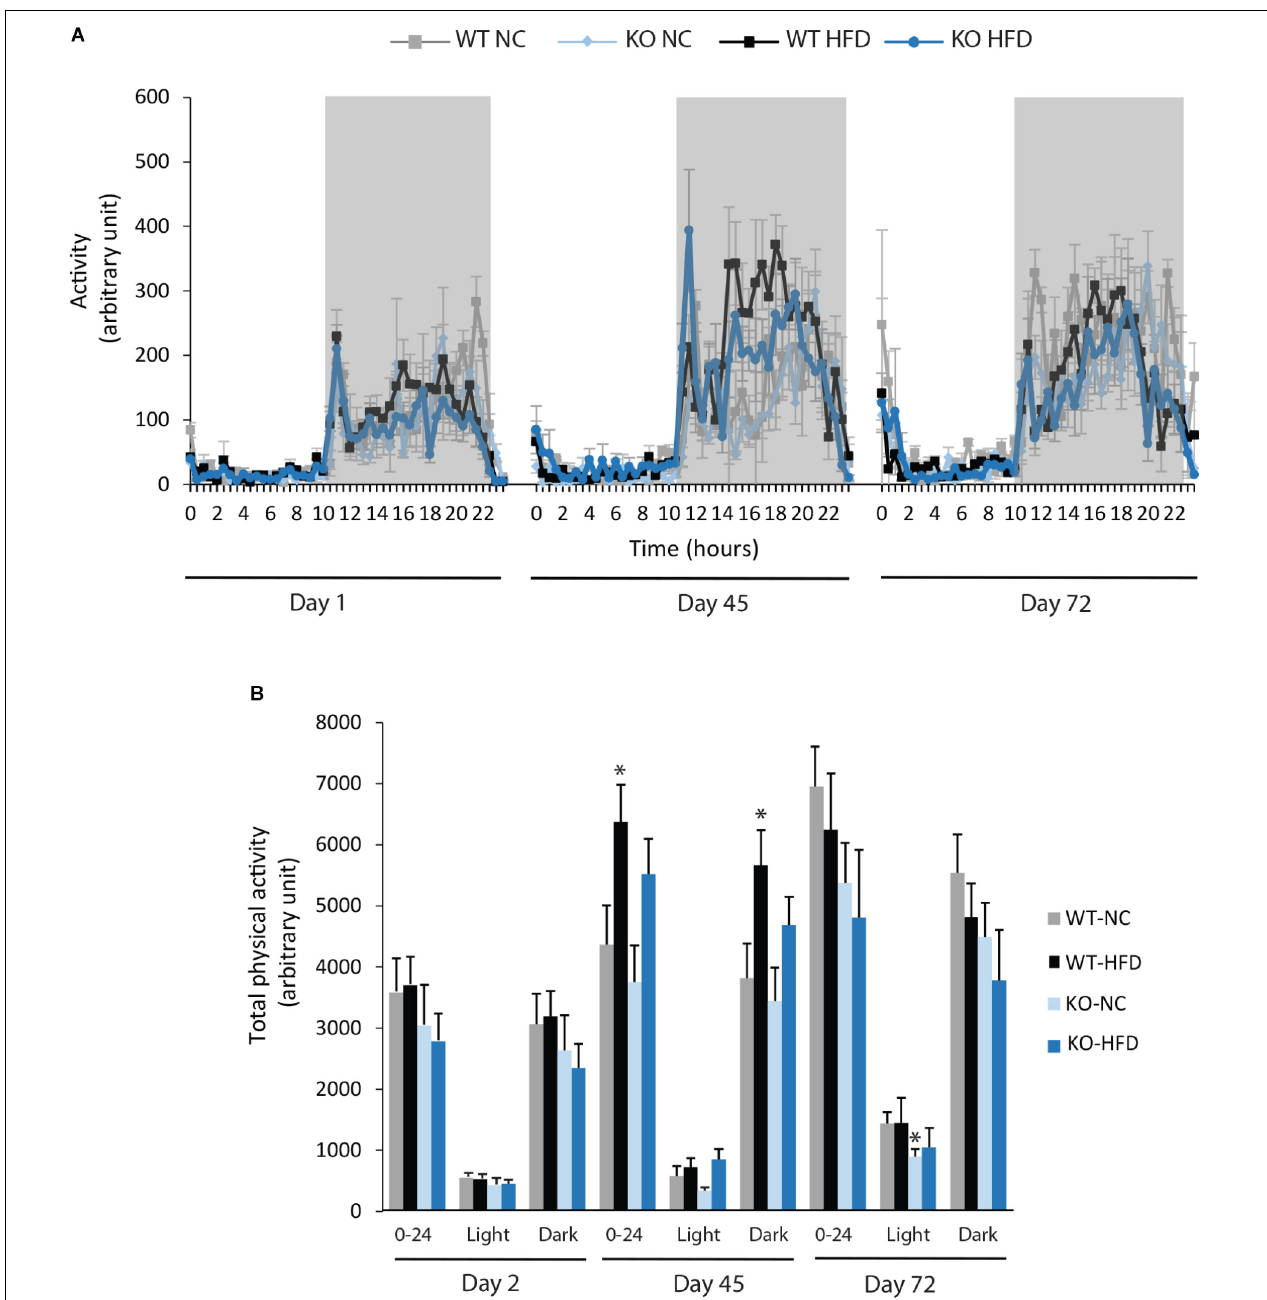
FIGURE 8 | Deletion of mPGES-1 did not modify total physical activity. (A) Monitoring of physical activity for all groups at three different time points (D1, D45, and D72). (B) Quantification of total daily (0–24 h), daytime and nighttime physical activity. Data shown are mean ± SEM; ∗ significantly different from WT-NC; and ∗ p <